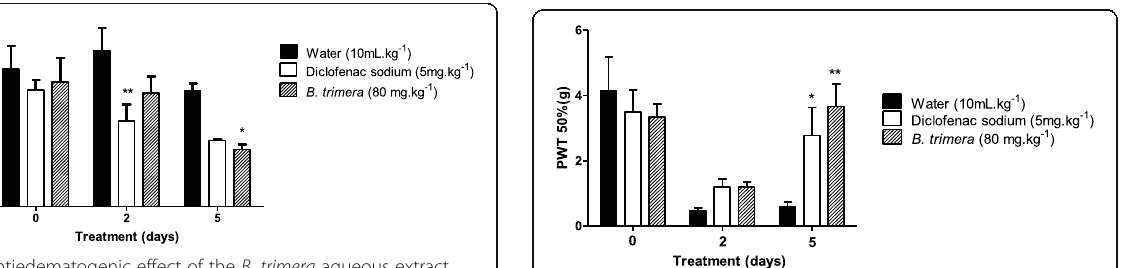
Fig. 3 Antiedematogenic effect of the B. trimera aqueous extract (80 mg/kg, p.o.) after the chronic inflammatory induction by FCA (i.pl.). Each bar represents the mean ± standard error of 14 – 15 mice. * p < 0.05 or ** p < 0.01 represents the level of significance when compared to the water-treated group (Two-Way ANOVA, followed by the Bonferroni test)